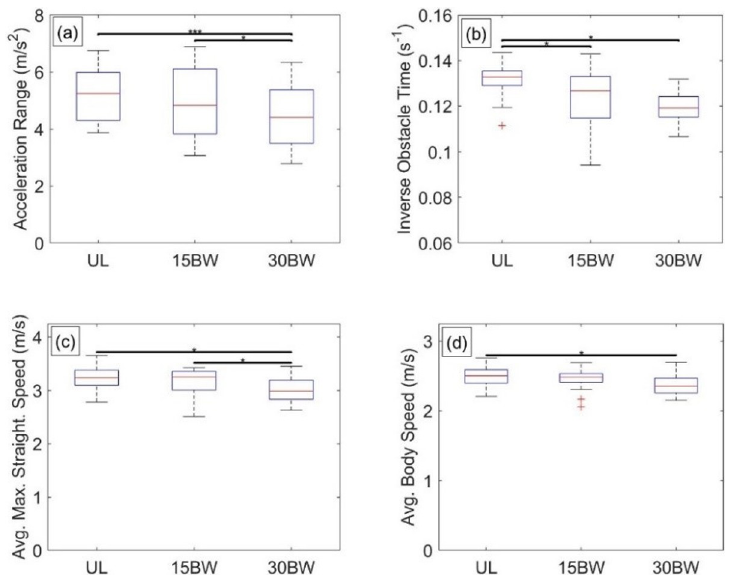
Fig 13. Agility run statistical results. Boxplots depicting the results from the Tukey post hoc analysis for a) acceleration range, b) (inverse) obstacle time, c) average maximum straightaway speed, and d) average body speed. The bars denote significant differences between loading conditions at a significance level α = 0.05 � , 0.01 �� , 0.001 ��� .